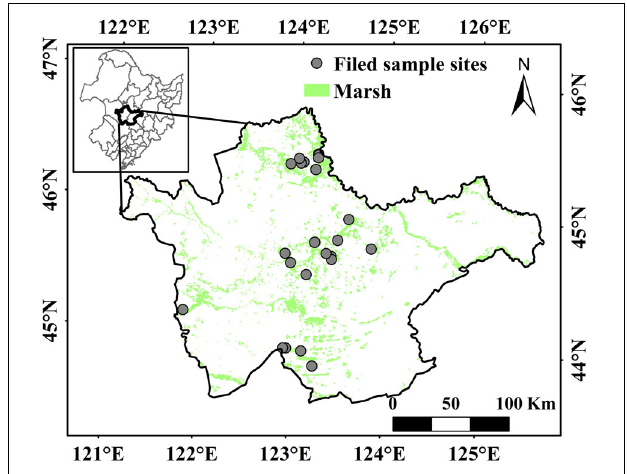
FIGURE 1 | Spatial distribution of marsh and aboveground biomass filed sampling points on the western Songnen